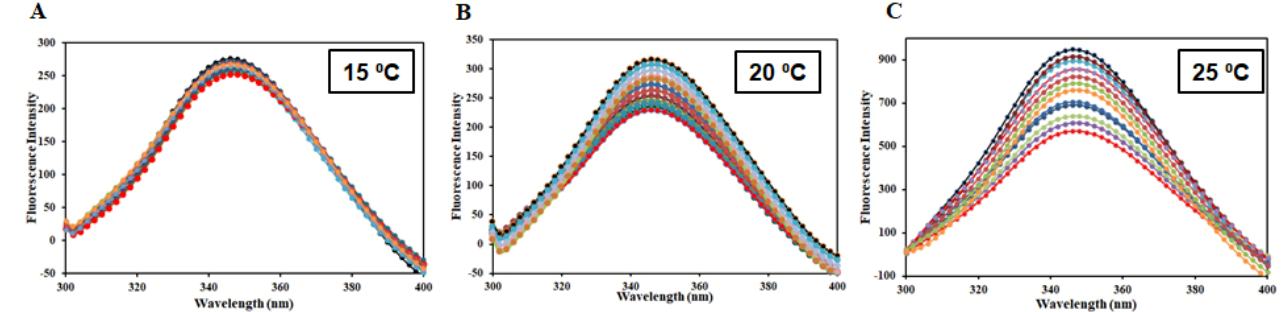
Figure 9. Fluorescence emission spectra of HSA in the absence and presence of varying HpzA concentrations (0–11 μ M) at ( A ) 15 °C, ( B ) 20 °C, and ( C ) 25 °C.